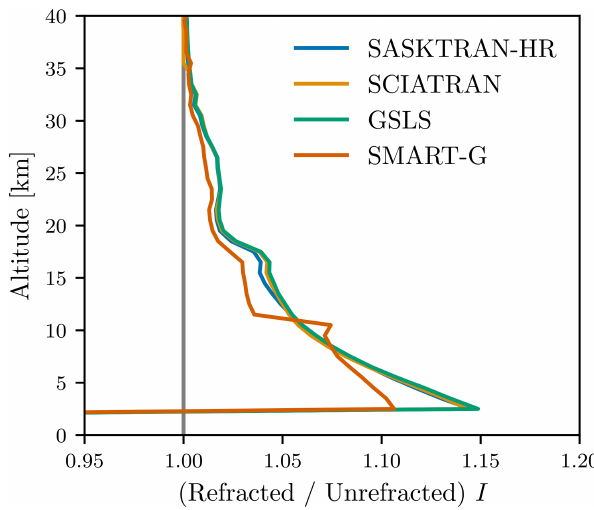
Figure 9. Ratio of refracted to unrefracted I with multiple scatter- ing enabled, Rayleigh scattering + ozone absorption + stratospheric aerosol scattering, SZA = 70 ◦ , SAA = 30 ◦ , and a Lambertian sur- face reflectance of 0 at 1020nm for every model that supports re-